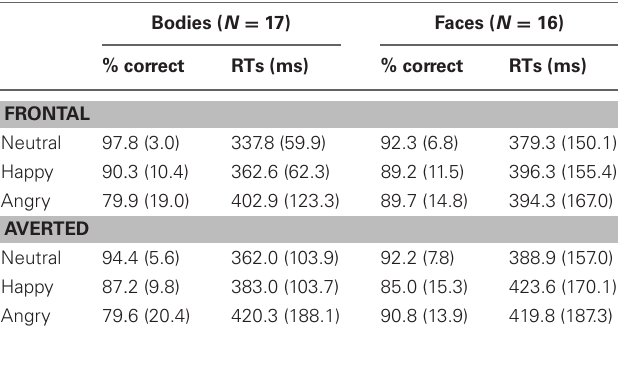
Table 1 | Response accuracies (% correct) and latencies (mean median ms) for the Body and Face Identification Tasks, computed separately for the two perspectives (frontal vs. averted) and three emotional expressions (neutral, happy, angry).